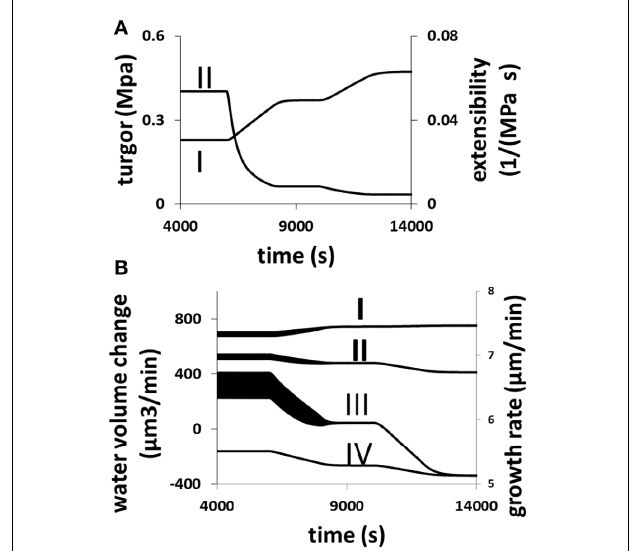
FIGURE 7 | Responses of a growing pollen tube to the change in the viscosity of cell wall. Osmolarity in the media is 0.18 Osm. Equilibrium viscosity, a parameter that affects the viscosity of cell wall Equation (6), changes as follows. t 1 = 6000s, t 2 = 8000s, t 3 = 10,000s, and t 4 = 12000s. Before t1: 25MPa s; between t1 and t2, linear increase from 25 to 125MPa s; between t2 and t3, 125MPa s; Between t3 and t4, linear increase from 125 to 225MPa s; after t4: 225MPa s. (A,B) Show the cellular responses. (A) Turgor increases (I) and cell wall extensibility (II) (cell wall extensibility is the inverse of the viscosity) decreases simultaneously. (B) Water flow from the media to the cell by osmosis (I) increases, and water flow from the cell to the media by turgor (IV) also increases. The overall result is that the net water flow from the media to the cell (II) decreases and therefore growth rate (III) also decreases. The wide black bands in this figure indicate the oscillations. The width of each band represents the oscillatory